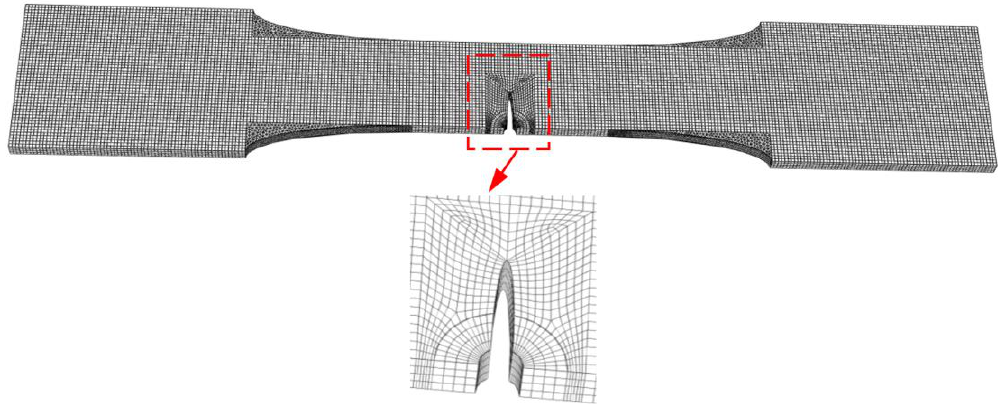
Figure 5. Finite element meshes of specimen B1.